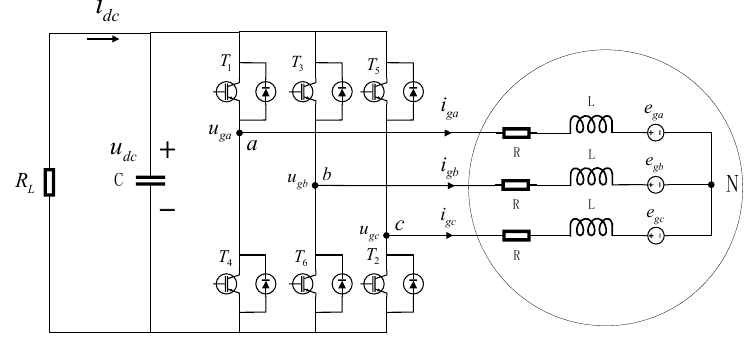
Figure 3. Topology of the network-side inverter.